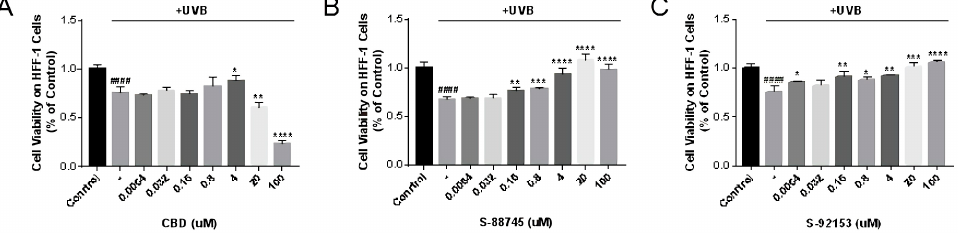
Figure 9. Cell viability of ( A ) CBD and its derivatives, ( B ) S-88745 and ( C ) S-92153, on HFF-1 cells. HFF-1 cells were treated with cannabidiol, S-88745 or S-92153 for 4 h, then UV intensity of 70 mW/cm was irradiated for 5 min. Following another 20 h, MTT assay was carried out to detect the cell viability. The experiments were repeated three times. Each bar illustrates the average ± standard deviation (SD) counted from three experiments. p < 0.05 was considered statistically significant.* p < 0.05 compared to the UV − treated group; ** p < 0.01 compared to the UV − treated group; *** p < 0.001 compared to the UV − treated group; **** p < 0.0001 compared to the UV − treated group; #### p < 0.0001 compared to the control group .